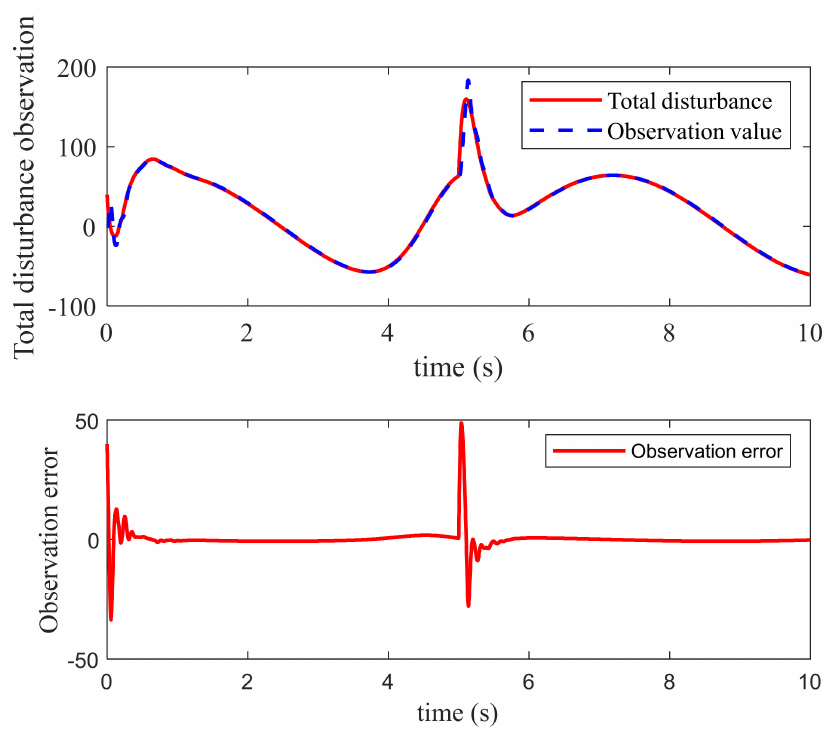
Figure 13. Time response of total disturbance